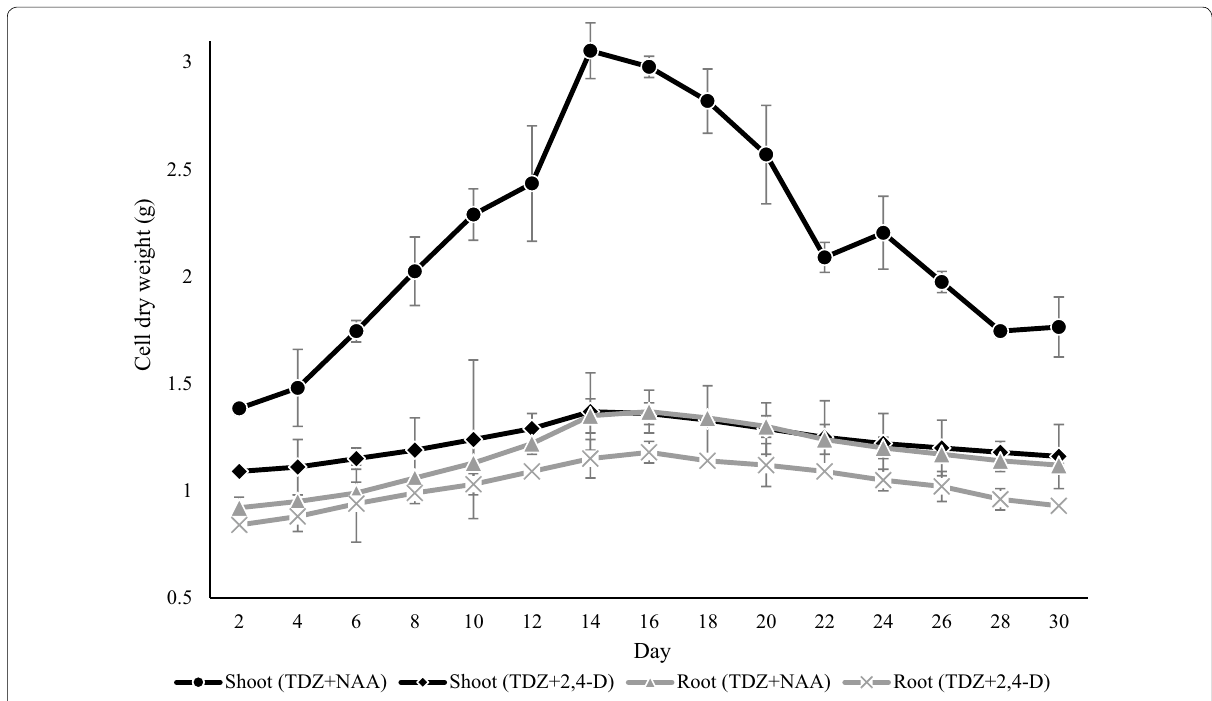
Fig. 3 Time-course analysis of growth rate in cell suspension cultures of T. parthenium in 30-day period